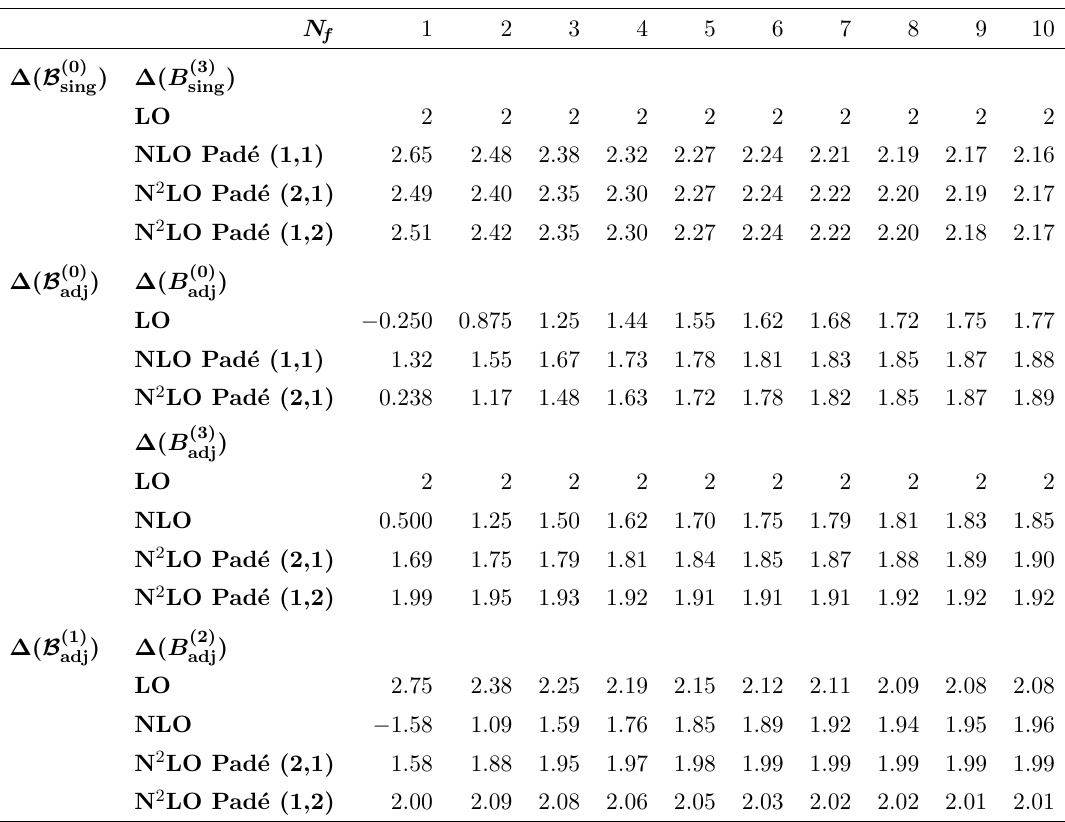
Table 4 . (cid:15) -expansion extrapolations of scaling dimension of the d = 3 bilinear operators B (0) B (0) , and the conserved current B (1) adj we list instead the values of the (cid:12)xed-order NLO prediction. Only three signi(cid:12)cant digits are being